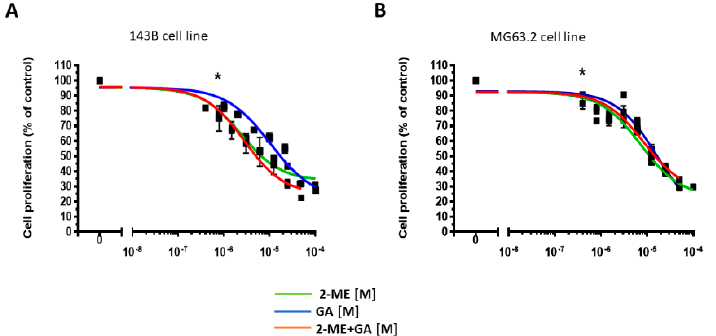
Figure 1. Anti-proliferative e ff ects of 2-methoxyestradiol (2-ME) and GA in 143B and MG63.2 cell lines. Anti-proliferative e ff ect of 2-ME or GA, or a combination of both compounds in OS 143B and MG63.2 cells. OS 143B ( A ) and M63.2 ( B ) were treated with series of dilutions (0.8 µ M–50 µ M) of either 2-ME or GA, or a combination of both (molar ratio 1:1). The cell proliferation was consequently determined by MTT assay. Data are presented as the mean ± SE values form at least three independent experiments. The absence of error bar denotes a line thickness greater than the error. Data were analyzed by GraphPad Prism Software version 6.02 performing One-way ANOVA combined with Dunett’s Multiple Comparison Test. * p < 0.01 versus control.